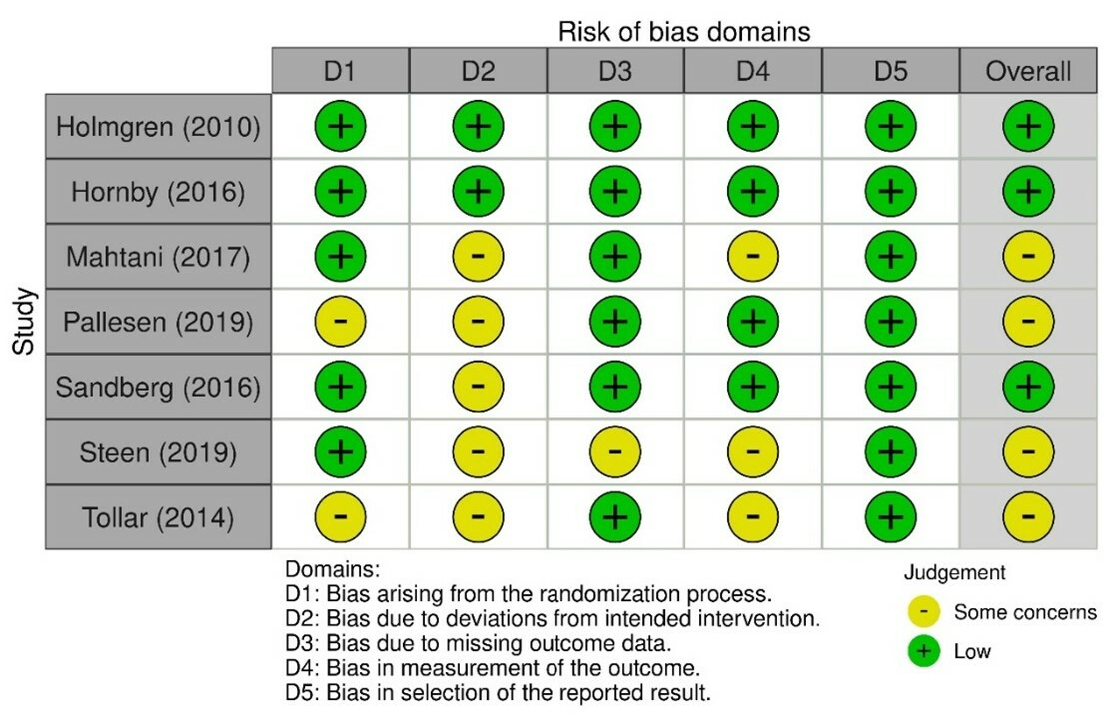
Figure 2. A consolidation of ROB2 outcomes in the included studies, adapted from: https://www.riskofbias.info/welcome/rob-2-0-tool/current-version-of-rob-2. (Accessed on 20 October 2022)